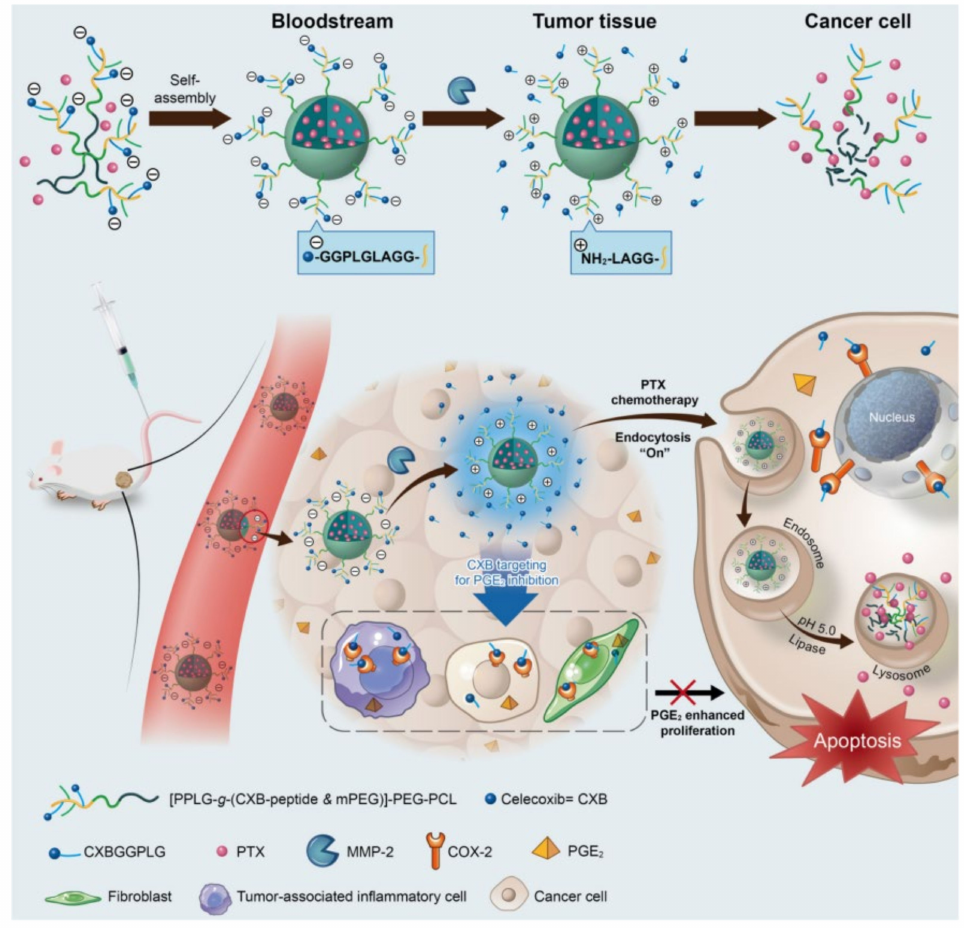
Figure 8. Combinatorial drug-loaded nanospheres capable of spatially sequential drug release using matrix metalloproteinase-2 (MMP-2) sensitive peptide. Celecoxib is first released into the tumor tissue by MMP-2, which is then activated in the tumor environment; paclitaxel (PTX)-loaded nanospheres are positively charged and internalized into cancer cells, and PTX is released intracellularly, causing apoptosis. Reproduced with permission from [38], American Chemical Society,